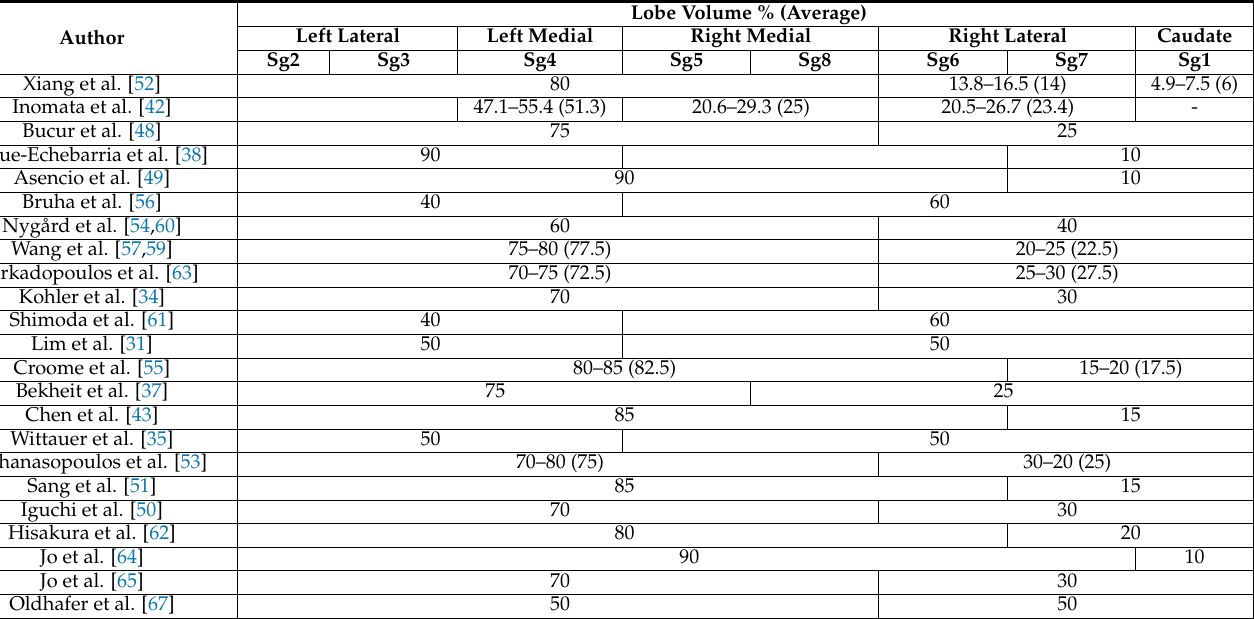
Table 3. Liver volume calculation in reported